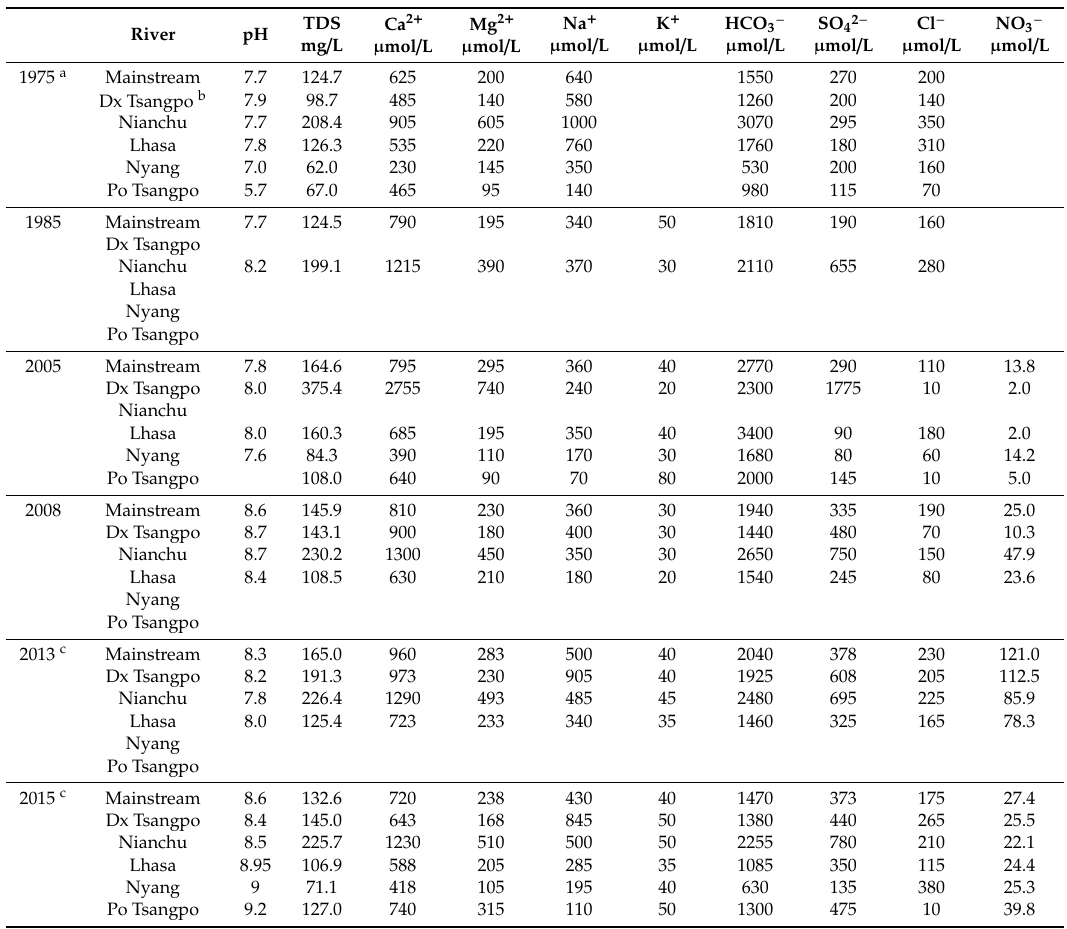
Table 3. Ion chemistry for the mainstream and tributaries in the Yalung Tsangpo River Basin during di ff erent